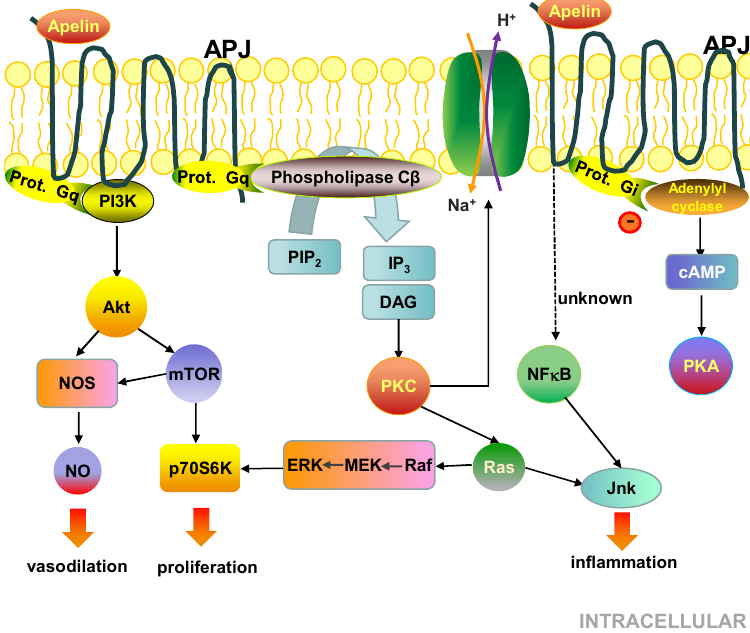
Figure 5. Molecular and cell signalling pathways of APJ.